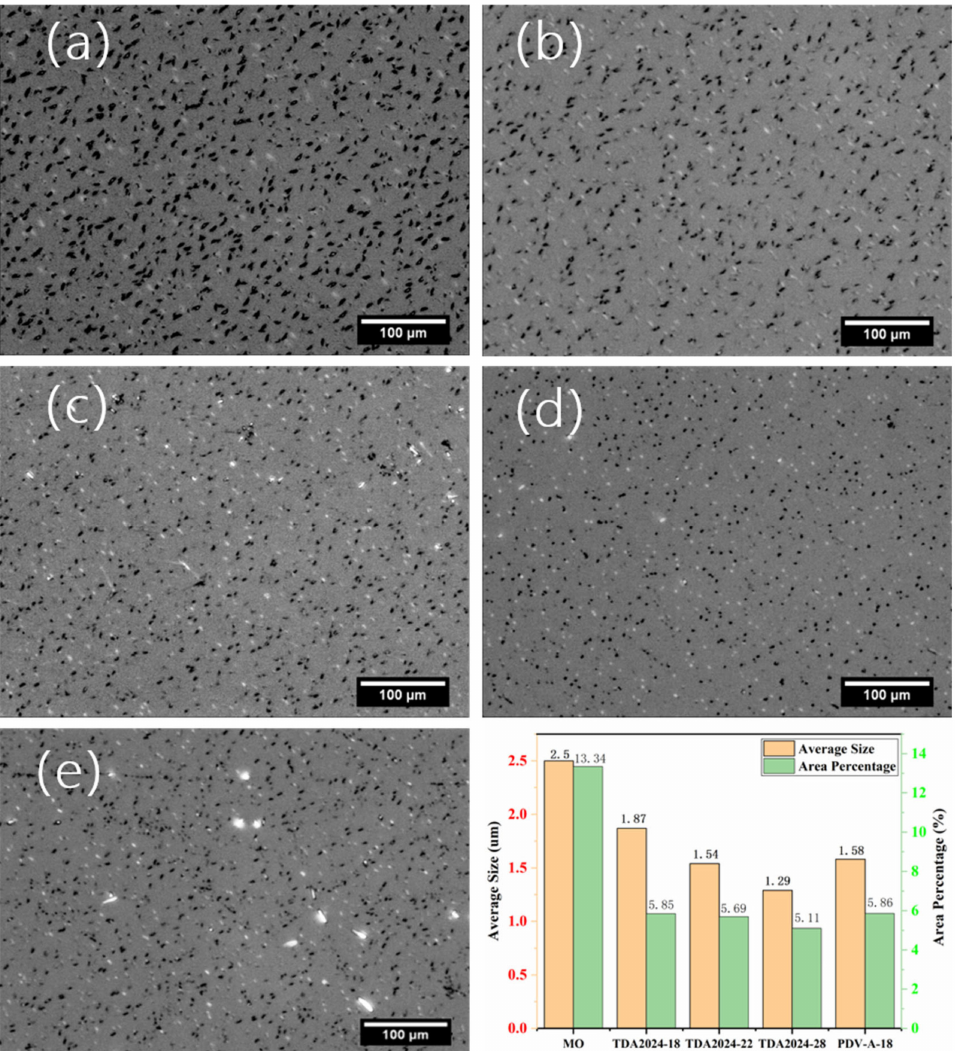
Figure 8. Microscopic images of asphaltenes in model oil with ( a ) no polymer and the addition of 500 ppm ( b ) TDA2024- 18, ( c ) TDA2024-22, ( d ) TDA2024-28 and ( e ) PDV-A-18, and the average diameter and occupied area of asphaltenes (corresponding to precipitation amount) using ImageJ